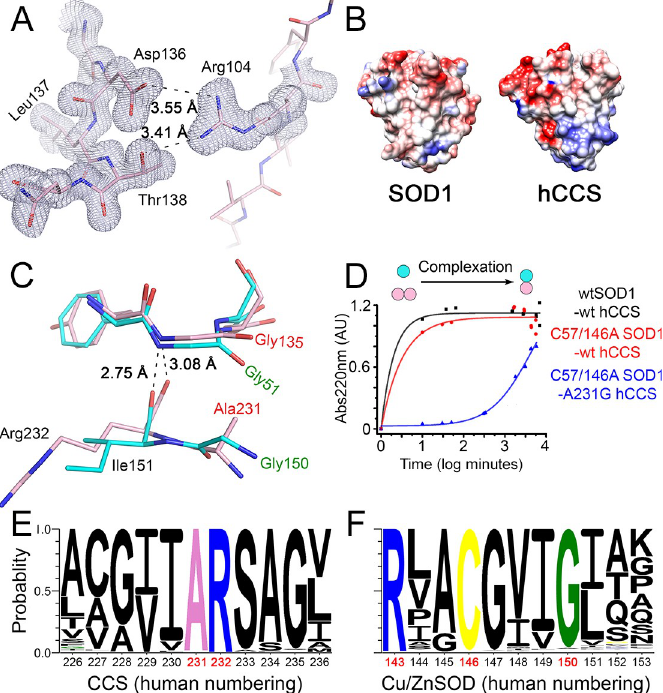
Fig 2. hCCS dimer interface destabilisation. ( A ) Electron density map (2Fo-Fc, contoured at 1 σ level) showing the Coulombic interaction between hCCS Arg104 and Asp136/Thr138. ( B ) Surface charge maps of hSOD1 and hCCS domain II dimer interface surfaces. ( C ) The hCCS (pink) dimer interface Arg232-Gly135 hydrogen bond is weakened by the steric effect of Ala231 side chain. The hCCS Gly135-Asp136 carbonyl rotates to accommodate the methyl group, and Gly135 is pushed away from Arg232. hSOD1 (cyan) Gly150 maximises hydrogen bond strength between Phe51 and Ile151. ( D ) Restoring SOD1-like dimer affinity with the Ala231Gly hCCS mutation vastly slows complexation. ( E ) Eukaryotic CCS sequence diversity shows Ala231 is very highly conserved despite its detrimental effect on homodimer affinity. ( F ) SOD1 Gly150 is equally well conserved, indicating the relative balance of SOD1 and CCS homodimer affinities is evolutionarily static. AU, absorbance unit; CCS, copper chaperone for SOD1; hCCS, human copper chaperone for SOD1; hSOD1, human superoxide dismutase-1; SOD1, superoxide dismutase-1; wt, wild-type.